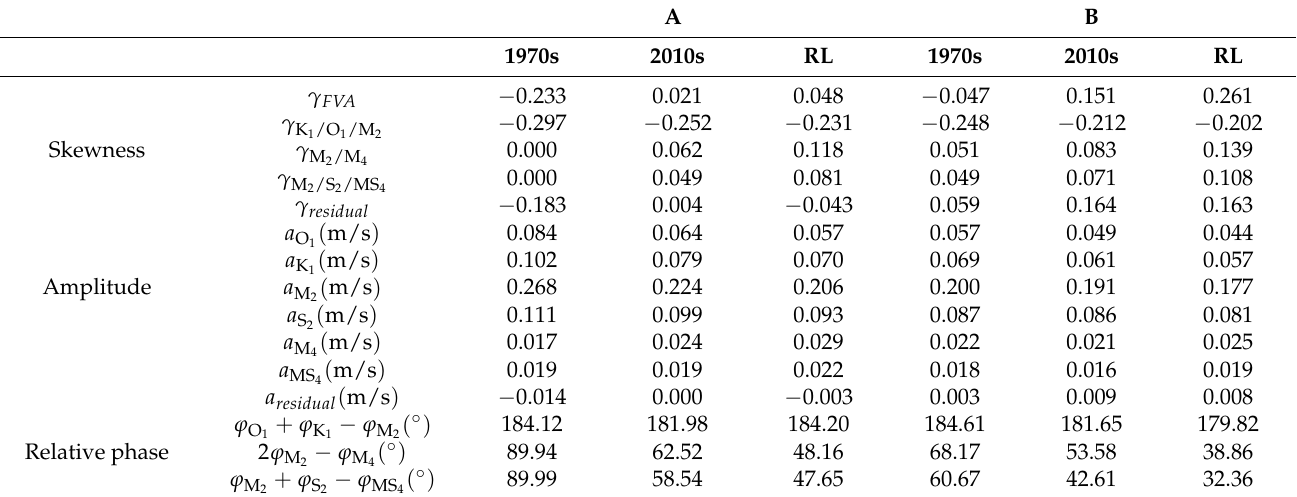
Table 1. Comparison of tidal harmonic parameters in different scenarios at points A and